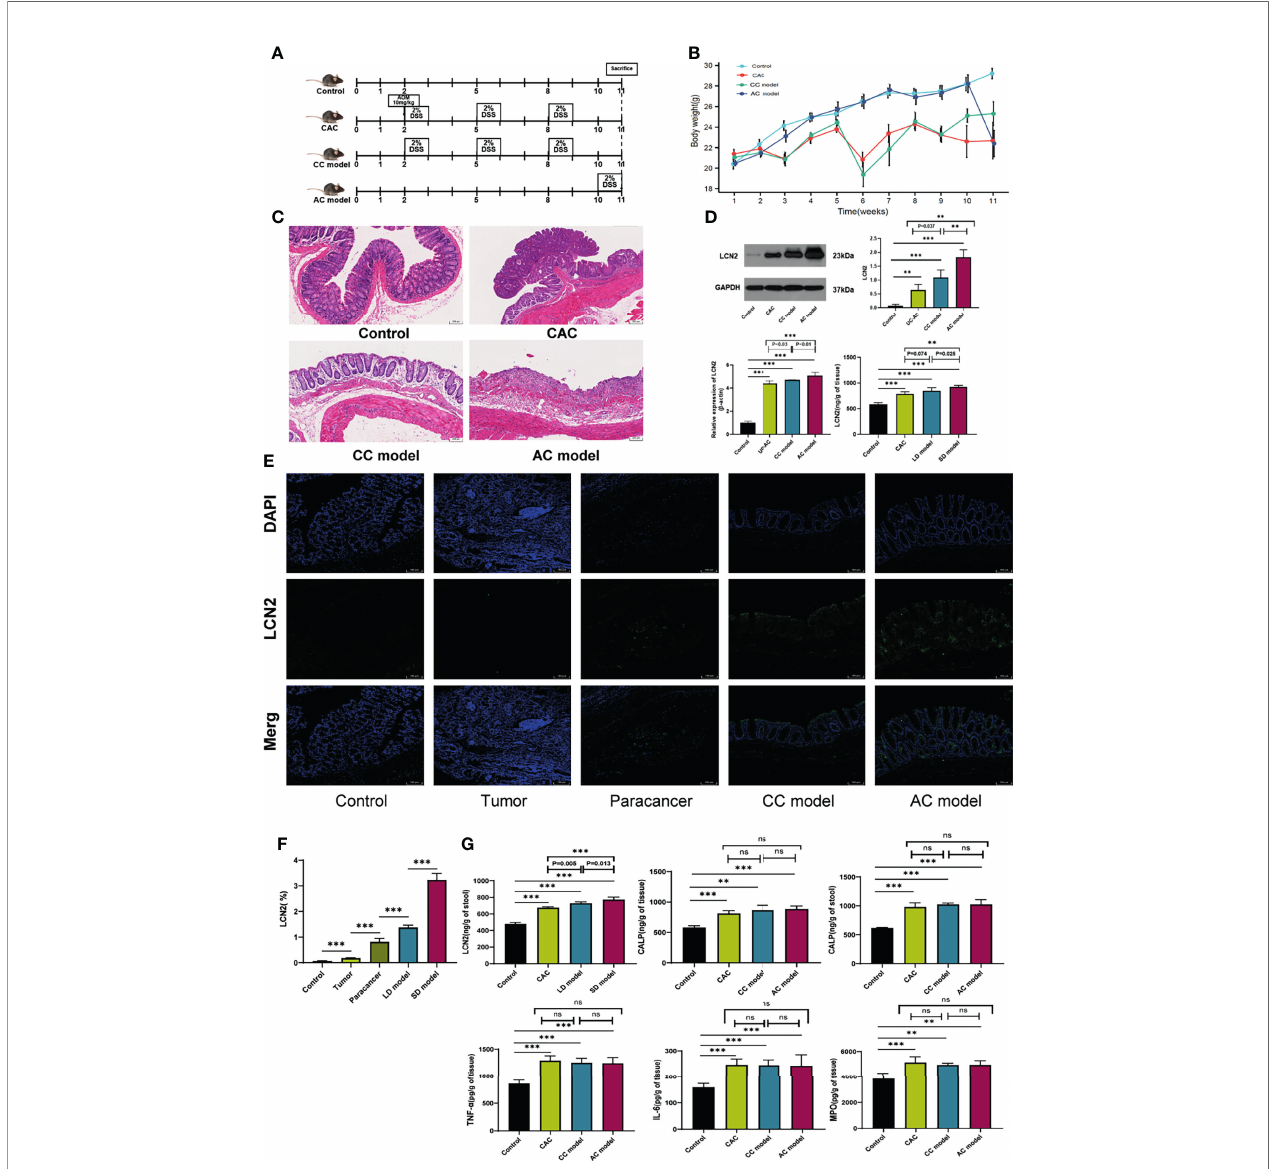
FIGURE 5 | Protein expression veri fi cation in animals. (A) Schematic overview of control, acute colitis (AC), chronic colitis (CC) model, and colitis-associated cancer (CAC) model. (B) Weight loss in mouse of control and three modeling groups. (C) H&E staining of colon sections of mouse at week 11. (D) Lipocalin-2 (LCN2) expression level in colorectal mucosa was detected by RT-PCR, Western blot, and ELISA. (E) Immuno fl uorescence of LCN2 in control, tumor, paracancer, long- duration (LD) ulcerative colitis (UC) model, and short-duration (SD) UC model. (F) Semiquantitative analysis of immuno fl uorescence images of LCN2. (G) Calprotectin (CALP), myeloperoxidase (MPO), interleukin (IL)-6, and tumor necrosis factor (TNF)- a expression levels in colorectal mucosa and LCN2 in stool were detected by ELISA. ** P < 0.01, *** P < 0.001; ns, not signi fi